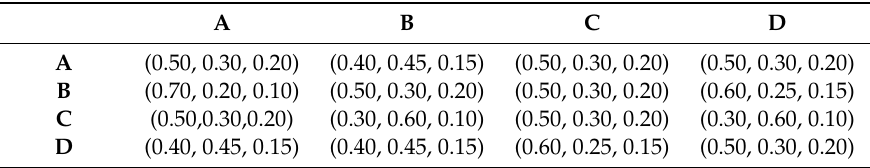
Table 7. Intuition fuzzy preference relationship of first-level indicators.